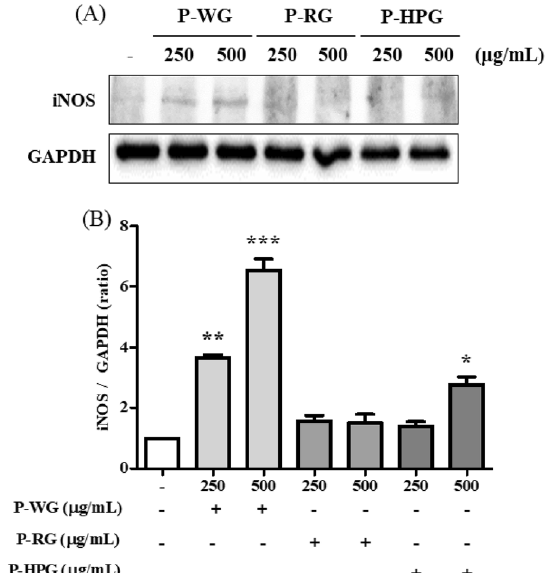
Fig. 7 Effects of P‑WG, P‑RG, and P‑HPG on nitric oxide (NO) production in RAW 264.7 macrophages. RAW 264.7 macrophages were stimulated with either a P‑WG, b P‑RG, or c P‑HPG at concentrations of 125, 250, 500, or 1000 μg/mL for 22 h.